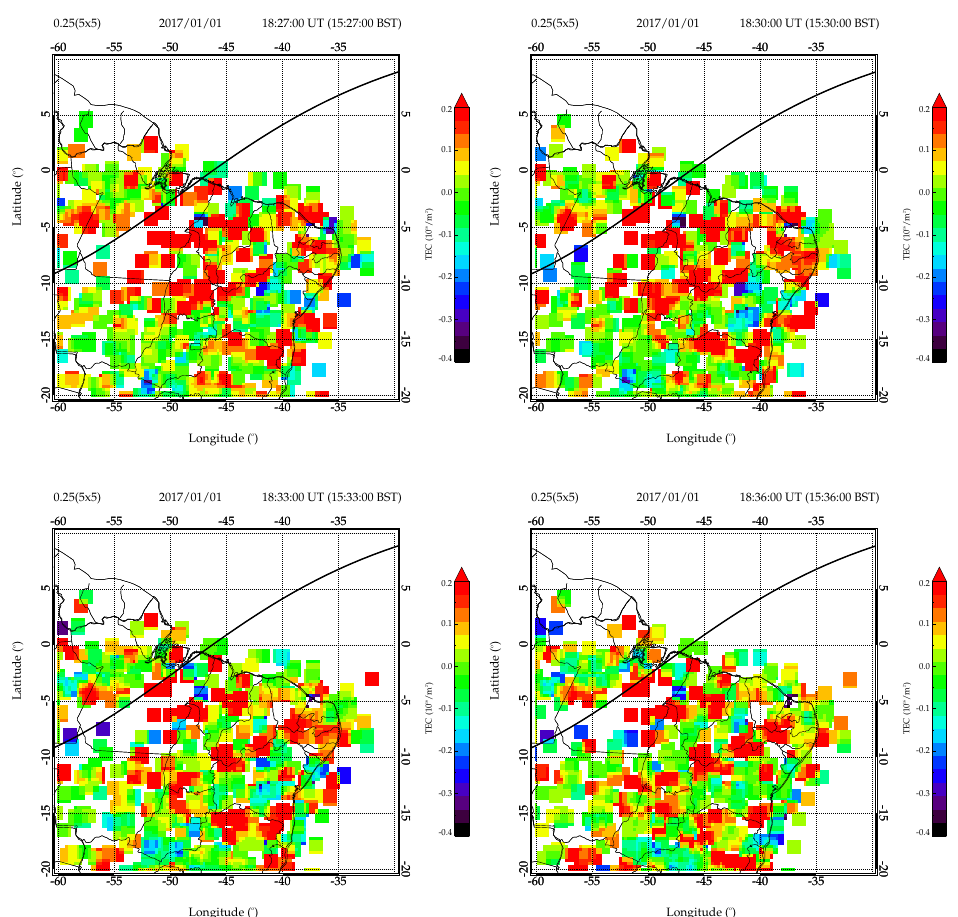
Figure 1. The series of dTEC maps on 1 January 2017 from 18:27:00 UT (15:27:00 LT) to 18:36:00 UT (15:36:00 LT) in 3 min time